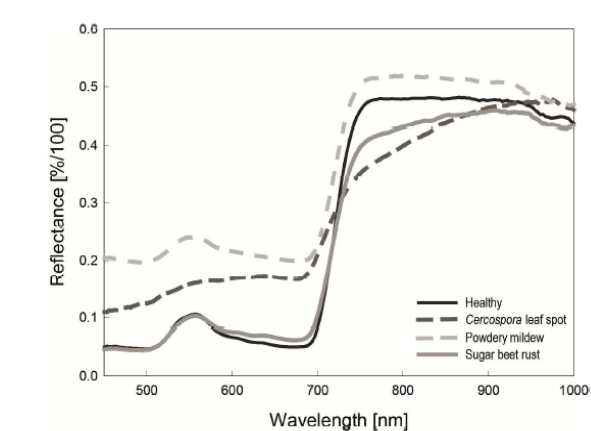
Figure 2: Spectral comparison of healthy and diseased sugar beet leaves (Khan, et al.,